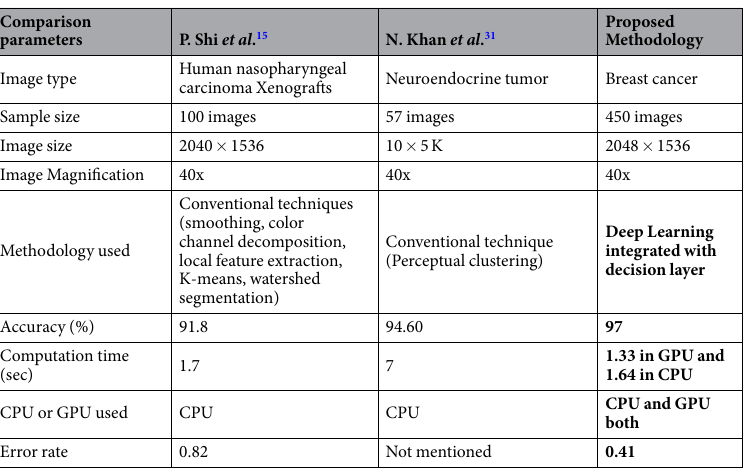
Table 7. Comparison with the existing